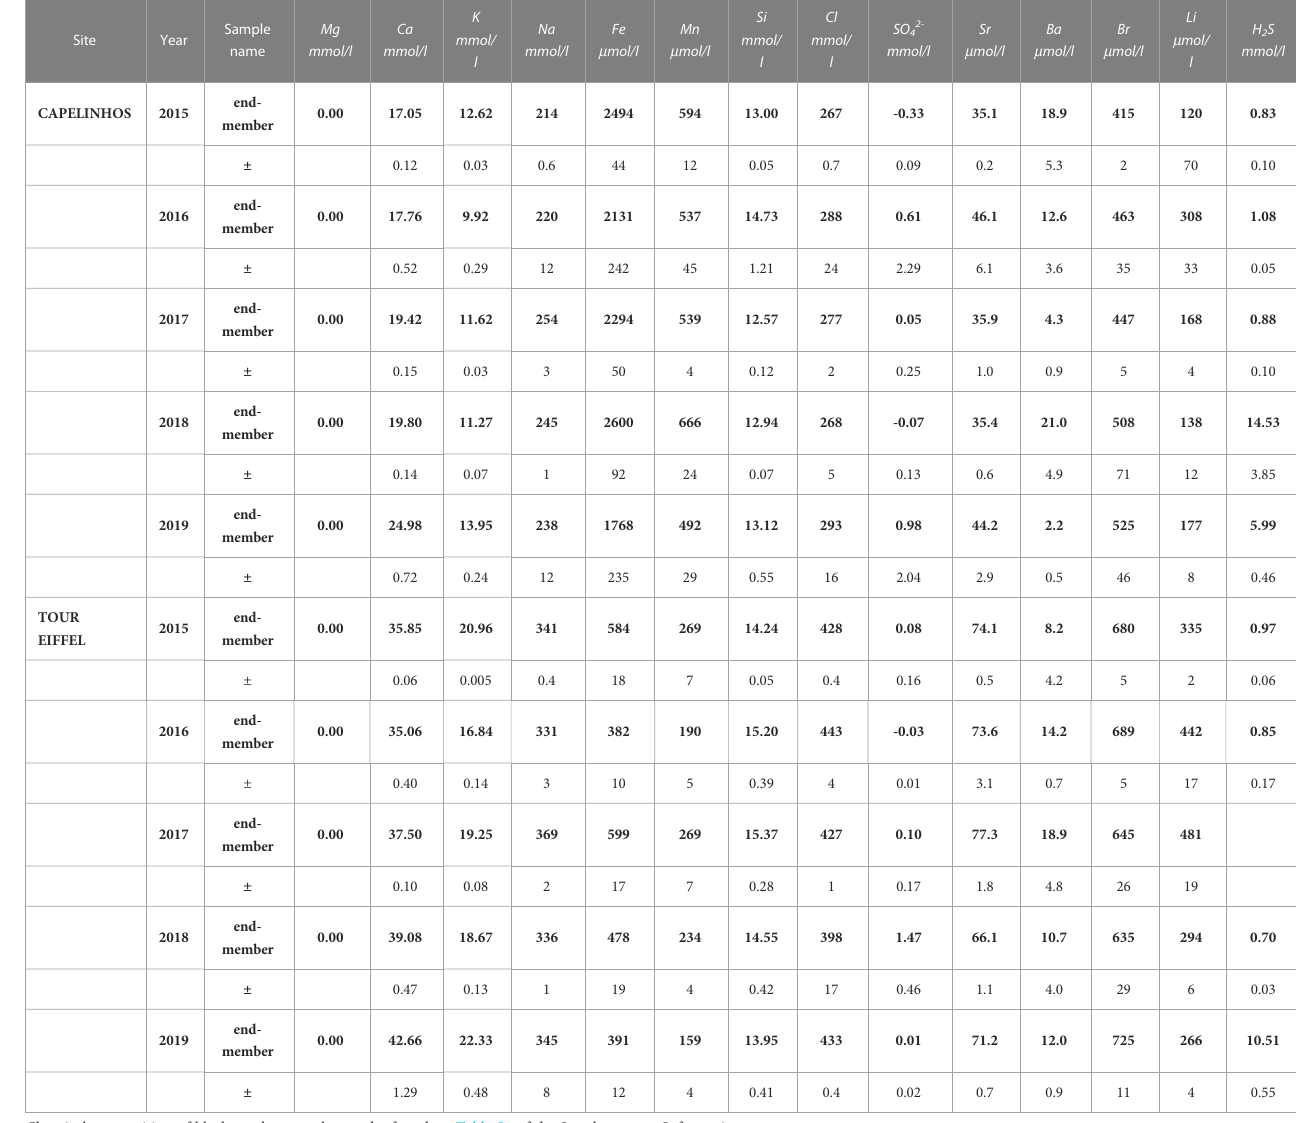
TABLE 1 Chemical composition of end-member hydrothermal fl uids calculated from the black smoker hydrothermal fl uids collected at Capelinhos and Tour Eiffel sites between 2015 and 2019.